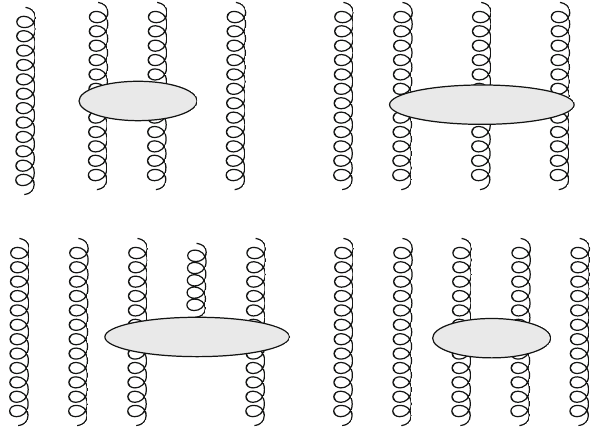
Fig. 13 Diagrams with rescattering of orders g 10 and g 12